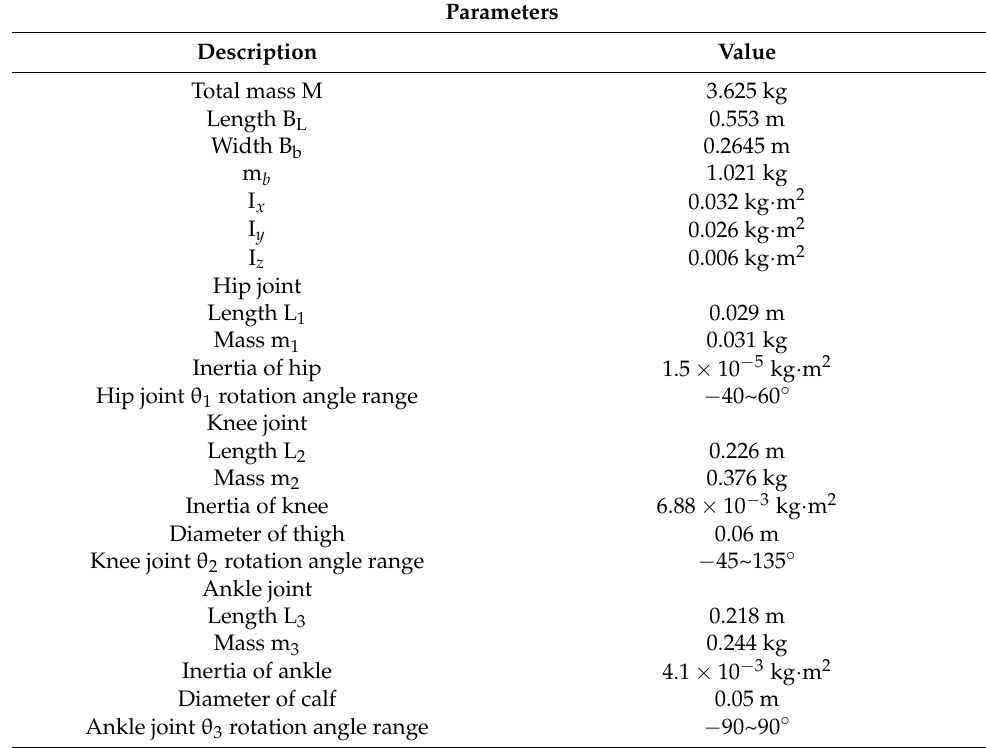
Table 1. Robot mechanical parameters.